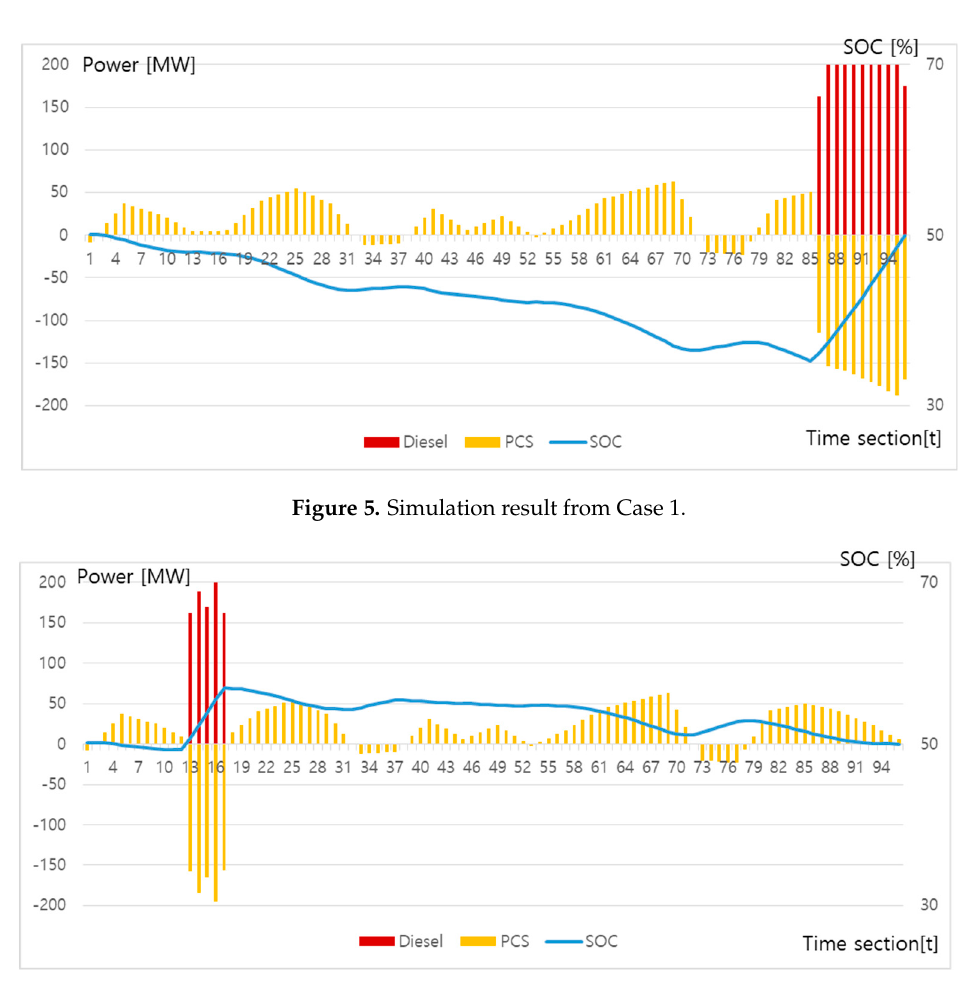
Figure 6. Simulation result from Case 2.